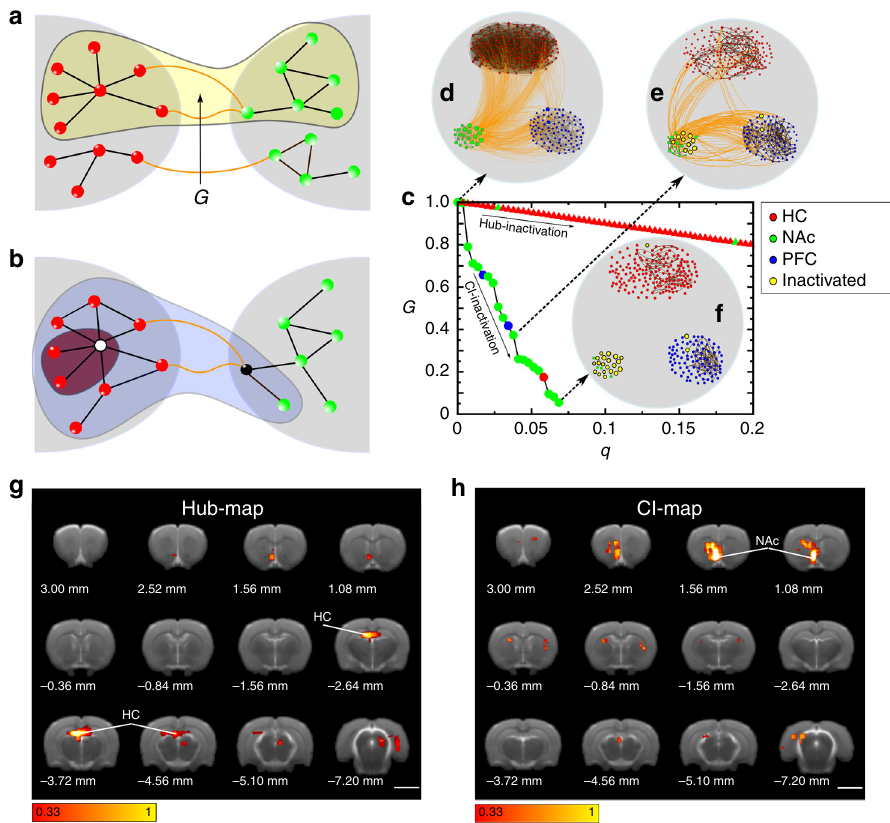
Fig. 2 Hub and Collective In fl uence map. a The giant (largest) connected component G (yellow) captures the integration of two modules into a brain network. b In fl uence of a hub and a CI node. Inactivation of the hub (white node) produces less damage to brain integration, measured by the size reduction of G , then the inactivation of the CI node (black). c Relative size of G as a function of the fraction of inactivated nodes, q . Two strategies are shown for choosing the essential nodes in a representative animal: Hub inactivation (triangles) and CI inactivation (circles). Nodes are removed one by one according to their degree or CI-score, respectively, from high to low. Colors refer to the nodes module (HC, NAc, or PFC, see legend). Most hubs (red symbols) are located in HC, yet, they are not essential for integration: their removal makes minimal damage to G . On the contrary, by inactivating 7% of high CI nodes, G collapses to almost zero. Most CI nodes are in the NAc (green symbols). d Representative brain network as in ( c ), displaying the PFC – HC – NAc networks. The size of each node is proportional to the CI score. e We inactivate the top 3% of high CI nodes (yellow circles) and G is drastically reduced to less than 40% of its original value. These top CI nodes are all in the NAc except for two nodes in the PFC. f Further inactivating up to 7% of the high CI nodes prevents integration of G . Yellow circles indicate the essential nodes, located mostly in the NAc shell. g Average hub map indicating top hub nodes over six animals. Yellow/white areas correspond to top essential nodes all located in the HC since this is the area of LTP induction. Color bar represents the average rank (Supplementary Eq. (8)). h Average CI map indicating top CI nodes over six animals, most CI nodes result in the NAc and are generally not hubs. Color bar is de fi ned in Supplementary Eq. (8), the size bar corresponds to 0.5 low-degree nodes as in fl uential as long as they are surrounded by connected component (shaded in blue). Removing the largest hub high-degree nodes in their spheres of in fl uence. (depicted in white) causes relatively less damage (shaded in red).